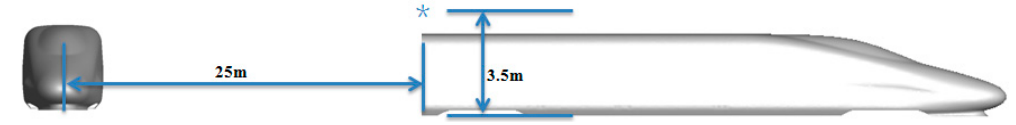
Figure 10. Schematic drawing of the observation probes in the far field.